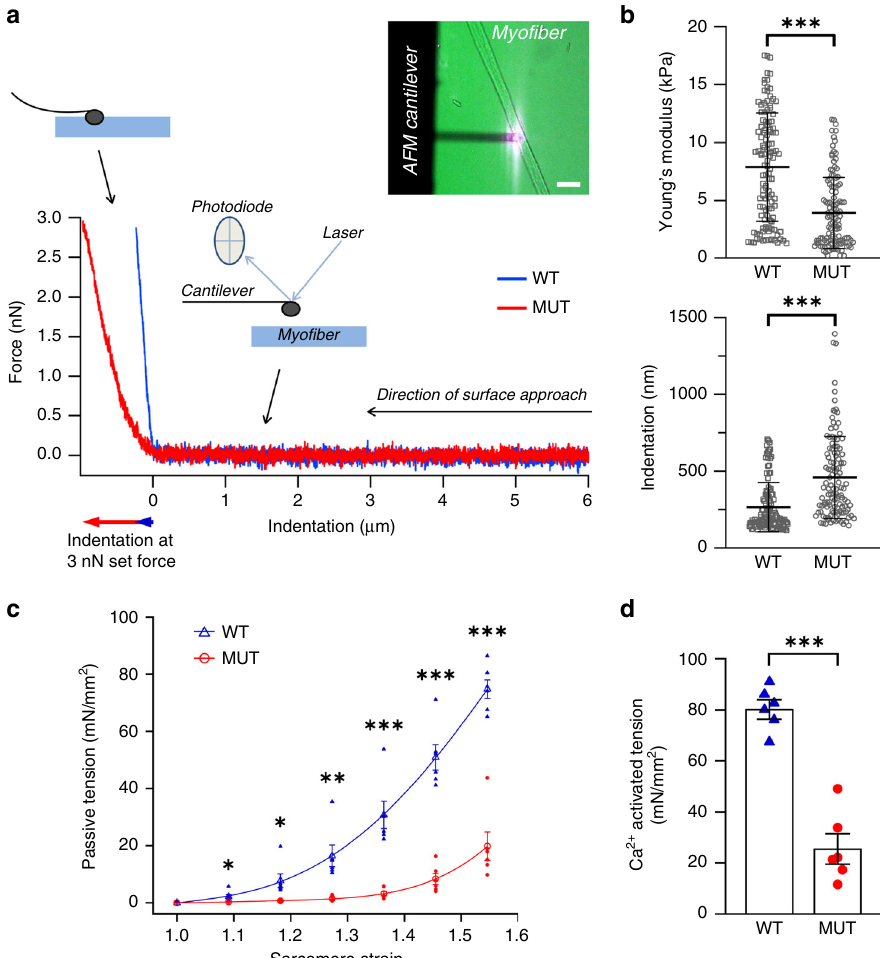
Fig. 4 Myo fi ber stiffness and tension from WT and MUT mice after ~30 days of dox-treatment. a Representative force-indentation curves for myo fi bers from WT (blue) and MUT (red) mouse pectoralis muscles after dox-treatment. Schematics indicate the principle of measurement by atomic